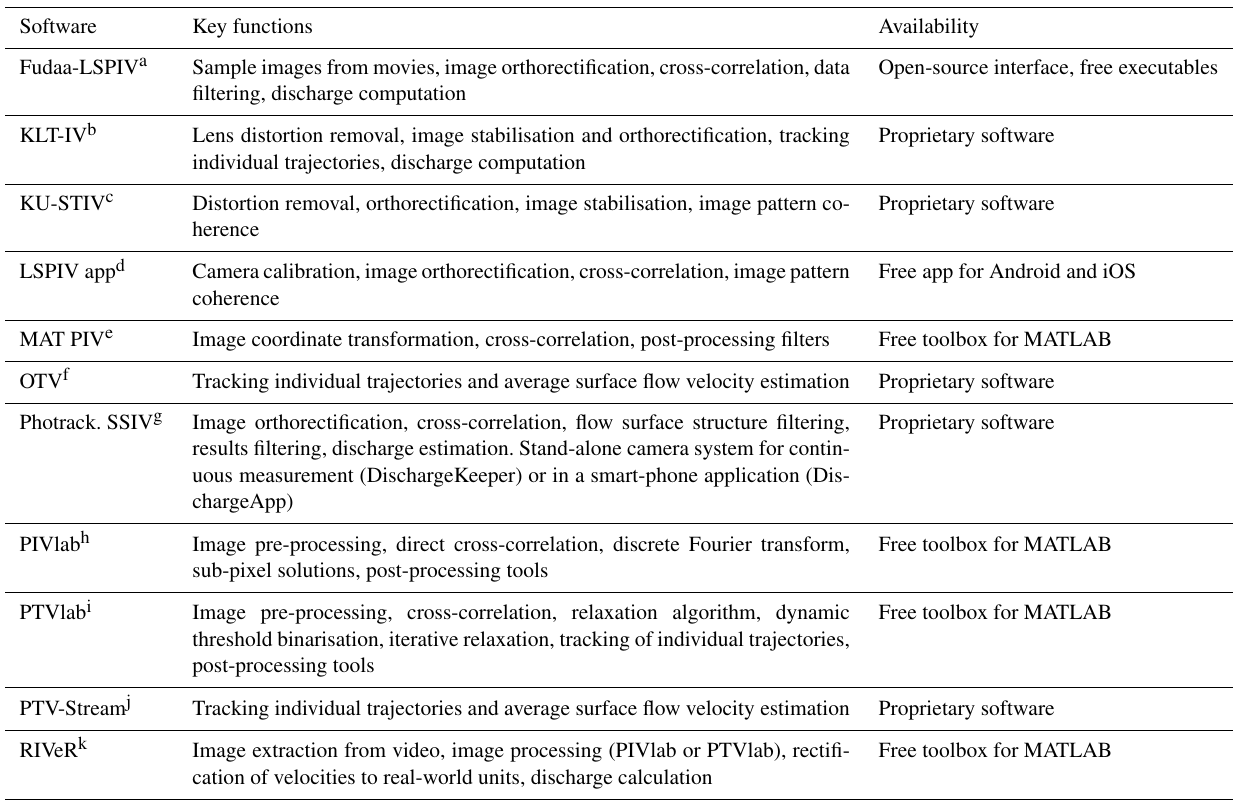
Table A1. Details of software developed for image velocimetry